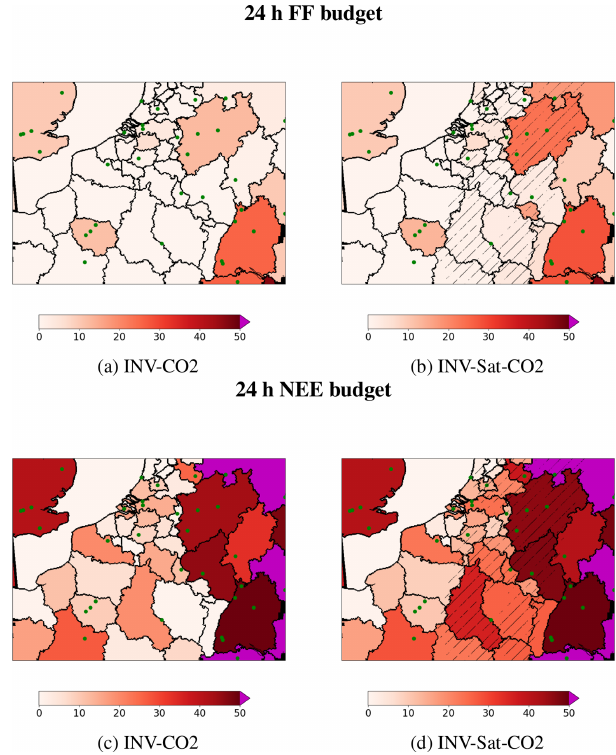
Figure 11. Uncertainty reduction in INV-CO2 (a, c) and INV-Sat- CO2 (b, d) inversions: for 24h budgets of FF emissions and bio- genic fluxes (NEE). Stripes are indicative of the satellite field of view. Green dots indicate the ground